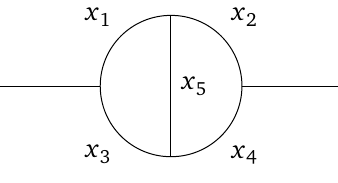
Figure 2: Two-loop self-energy diagram corresponding to the function M